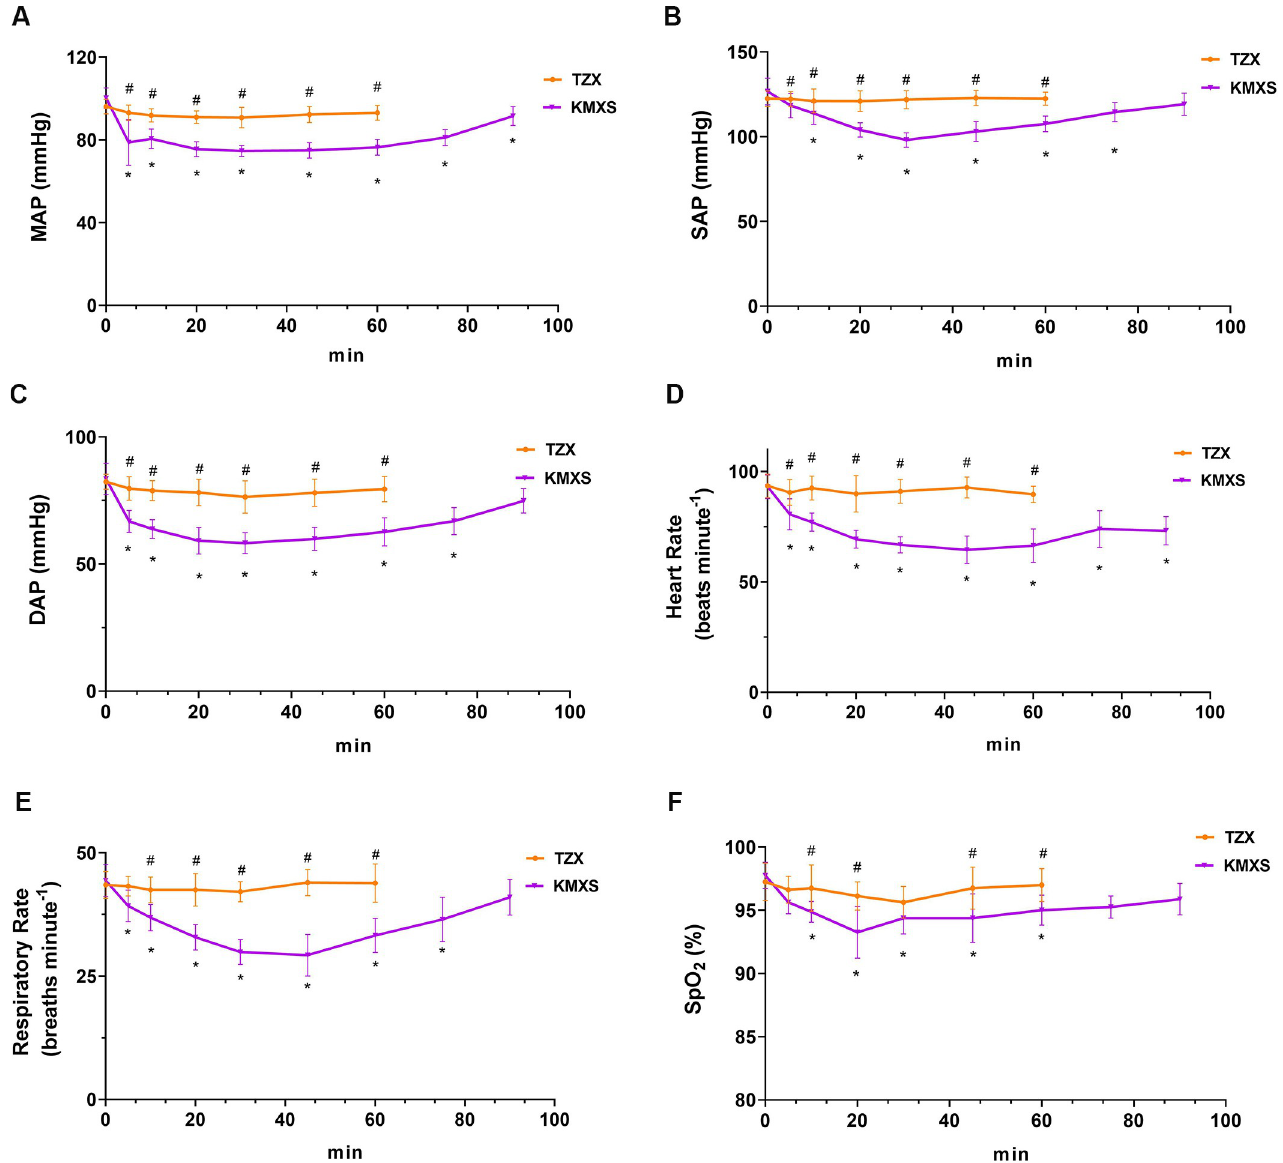
Fig 2. Cardiopulmonary variables in pigs (n = 8) that were administered with with KMXS or TZX protocol at phase 1. (A) mean arterial pressure (MAP), (B) systolic arterial pressure (SAP), (C) diastolic arterial pressure (DAP), (D) Heart rate (HR), (E) Respiratory rate (RR), and (F) peripheral hemoglobin oxygen concentration (SpO 2 ). KMXS protocol, 10 mg kg -1 ketamine, 0.5 mg kg -1 midazolam, and 2 mg kg -1 xylazine, plus 2 μ g kg -1 sufentanil. TZX protocol (n = 8), 4.4 mg kg -1 tiletamine-zolazepam plus 1.4 mg kg -1 xylazine. Values are expressed as mean ± standard deviation (SD). � Significantly different from baseline at the same group ( p < 0.05); # Significantly different between treatment groups ( p <